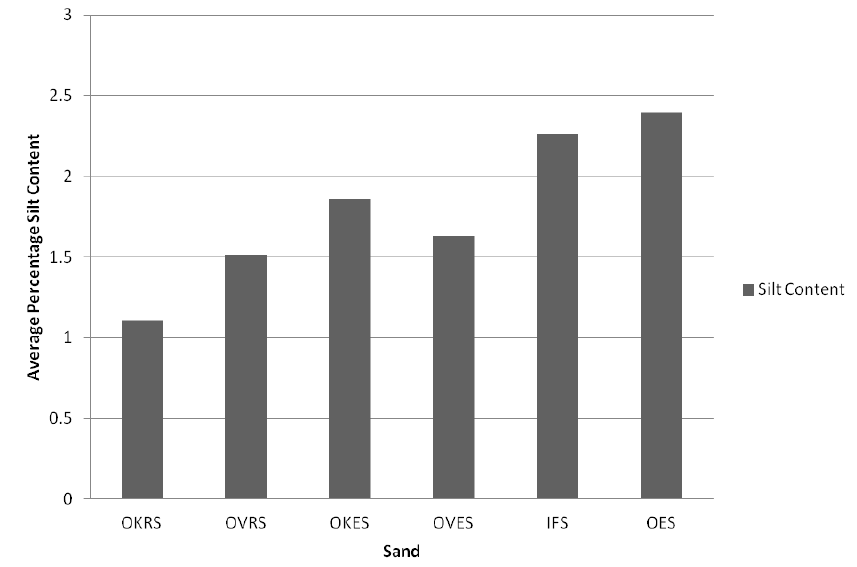
Figure 8. Silt content profile of all the various